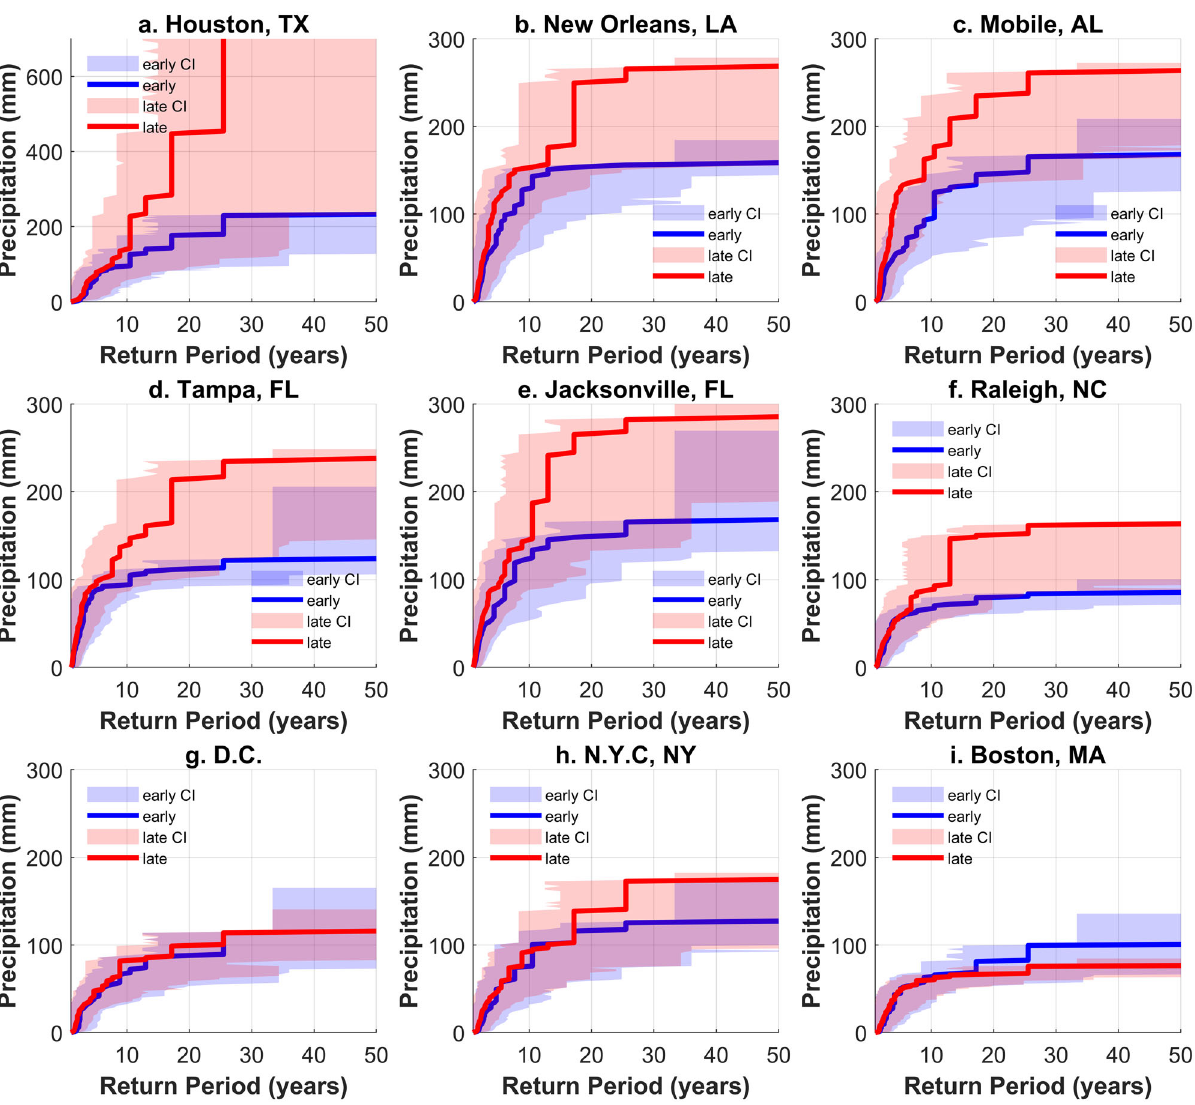
Fig. 3 Return Period (RP) for event Tropical Cyclone Precipitation (TCP) calculated for U.S. cities by the empirical kernel density function of exceedance probability. Each panel represents: a Houston, TX. b New Orleans, LA. c Mobile, AL. d Tampa, FL. e Jacksonville, FL. f Raleigh, NC. g District of Columbia, D.C. h New York City, N.Y.C, NY. i Boston, MA. Con fi dence Intervals (CI) are estimated by the upper (95%) and lower (5%) boundaries of the Poisson